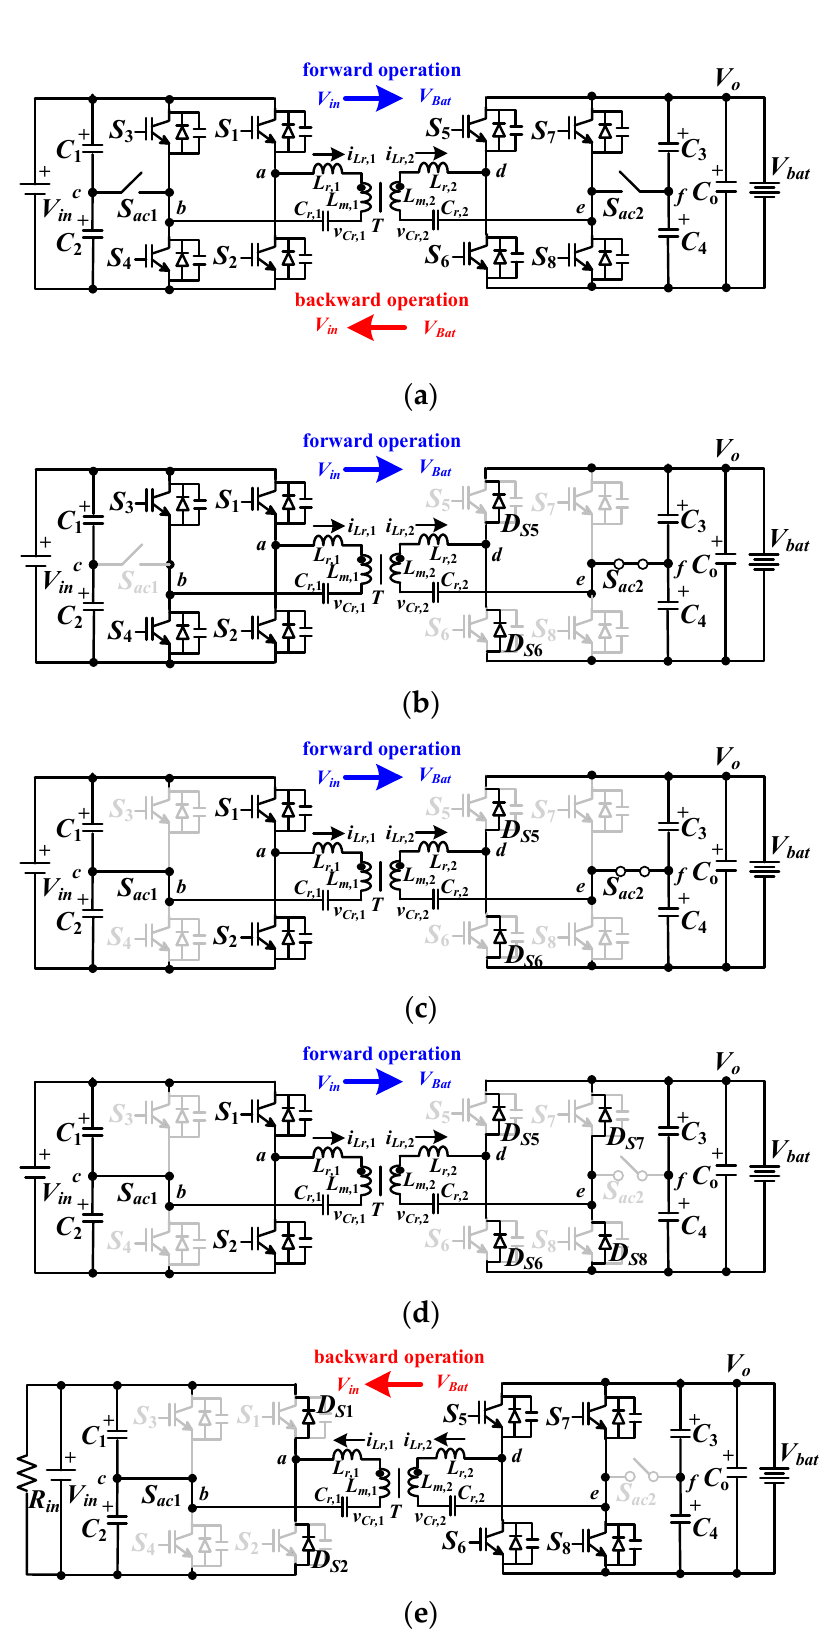
Figure 1. Presented hybrid DC converter: ( a ) circuit structure; ( b ) low voltage range input under forward power flow; ( c ) forward power flow; ( c ) medium voltage range input under forward power flow; ( d ) high voltage medium voltage range input under forward power flow; ( d ) high voltage range input under forward power flow; ( e ) range input under forward power flow; ( e ) under baclward power flow under baclward power flow operation.